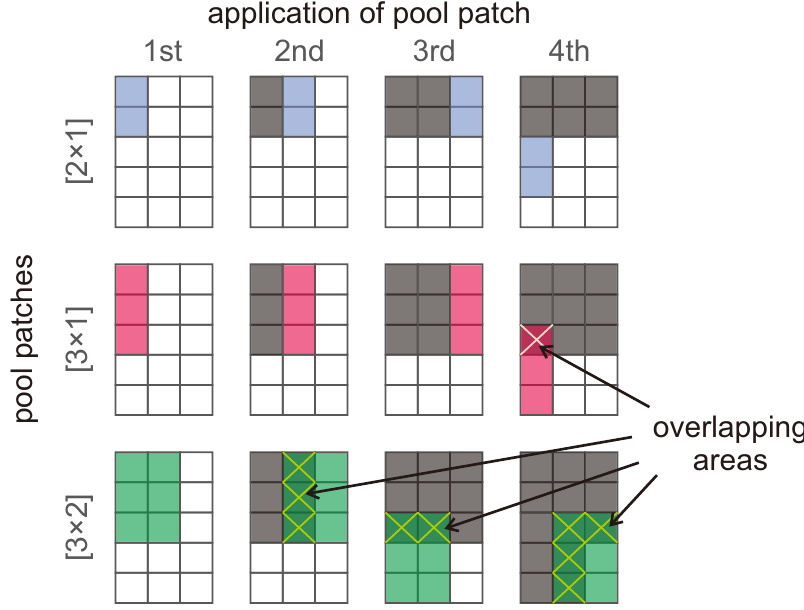
Figure 3. Proposed pooling patches applied on a 5 × 3 structure to show overlapping caused by the fixed pooling stride. Gray areas represent those in which the patch has been applied, and dark-colored areas are those in which the patch overlaps with previous